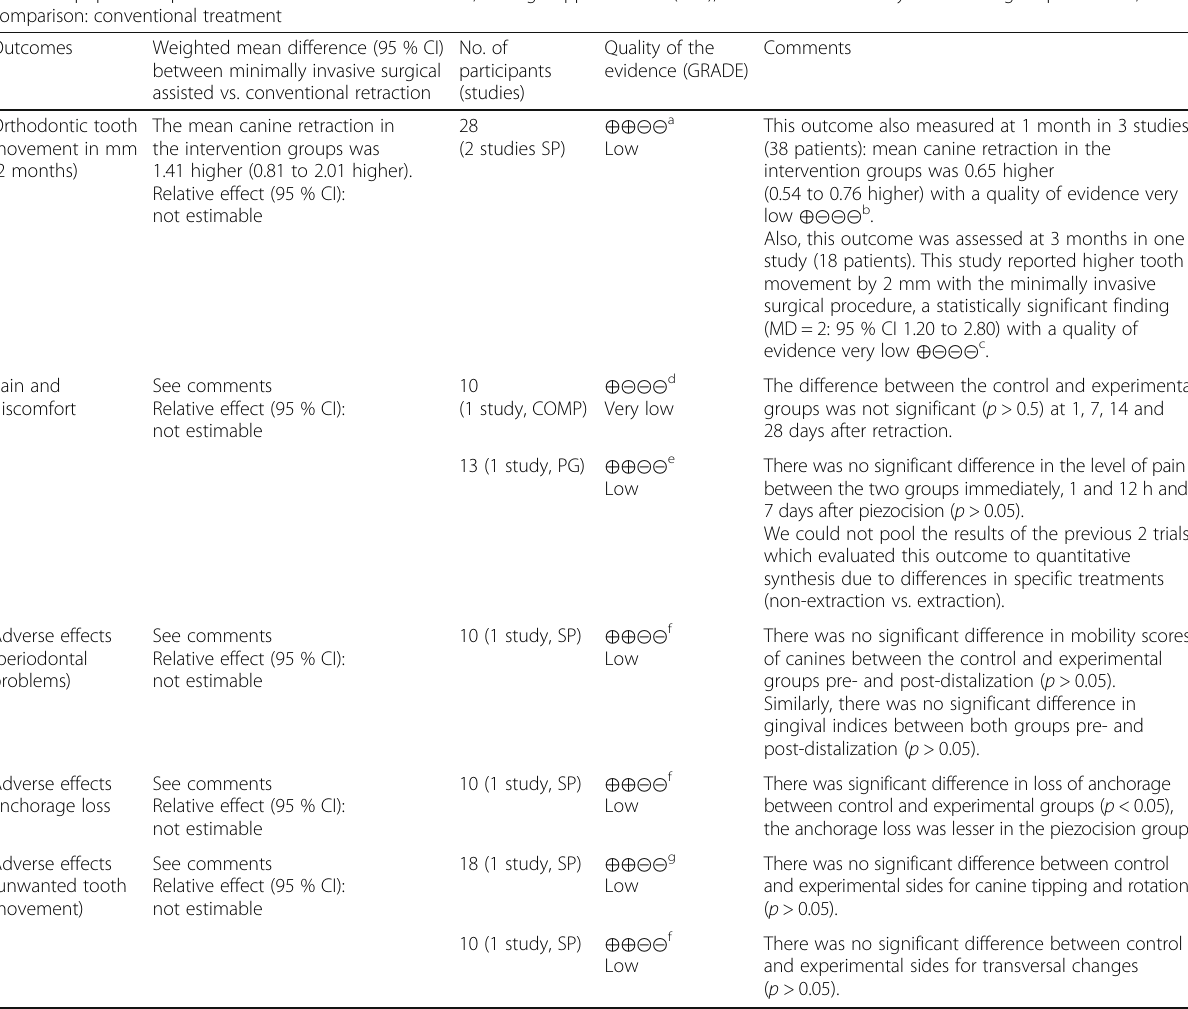
Table 3 Summary of findings table according to the GRADE guidelines for the included trials Patient or population: patients need orthodontic treatments, settings: upper canines (RCT), intervention: minimally invasive surgical procedures, comparison: conventional